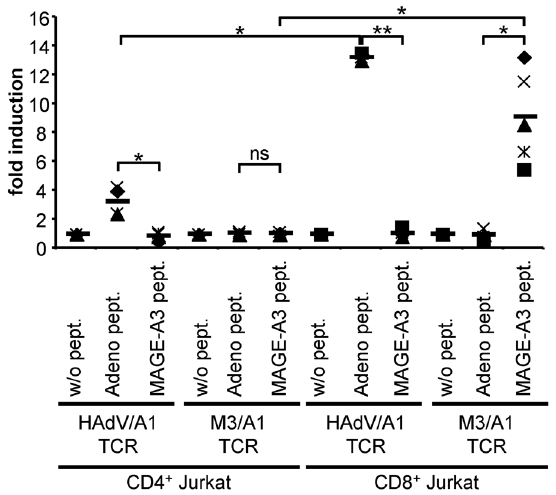
Figure 1. The newly cloned HAdV/HLA-A1-specific TCR is functional in Jurkat T cells. Parental CD4 + and transgenic CD8 + Jurkat T cells were co-electroporated with RNA encoding the HAdV/A1- specific TCR or MAGE-A3/A1 (M3/A1)-specific TCR and an NFAT- inducible luciferase reporter plasmid. These Jurkat T cells were stimulated with DC either non-loaded (w/o pept.) or loaded with the adenovirus peptide (Adeno pept.) or the MAGE-A3 peptide (MAGE-A3 pept.) (as indicated). The luciferase activity was measured, and the specific activation of the Jurkat T cells was calculated as fold induction by dividing the luciferase activity induced by peptide-loaded DC by that of similarly electroporated Jurkat T cells stimulated with non-loaded DC. Data of 4 (CD4 + Jurkat T cells) and 5 (CD8 + Jurkat T cells) individual experiments are shown. Bars indicate mean values. P-values were calculated by the Mann-Whitney U test. ns = not significant; ** p # 0.01;